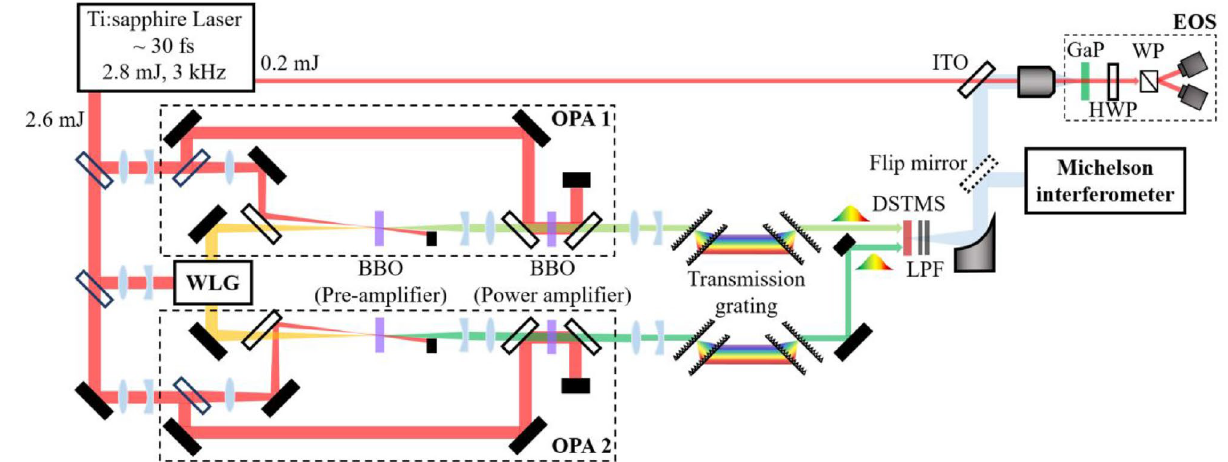
Figure 1. Experimental setup for generating narrowband, strong THz fields, composed of two high-efficiency OPAs. A laser pulse with 2.8 mJ is separated to pump two identical two-stage OPAs seeded by the same white light generation (WLG) system, and to probe for electro-optic sampling (EOS). Each separated beam is down- collimated by a Galilean telescope. The signal output from each OPA is chirped by a pair of high-efficiency transmission gratings and utilized for the DFG process in a DSTMS crystal. The generated THz pulses are extracted by a pair of low pass filters (LPF) and characterized by either interferometric autocorrelation or EOS in a GaP crystal. The EOS setup consists of a half-wave plate (HWP), a Wollaston prism (WP), and two fast photodiodes in a balanced detecting configuration.